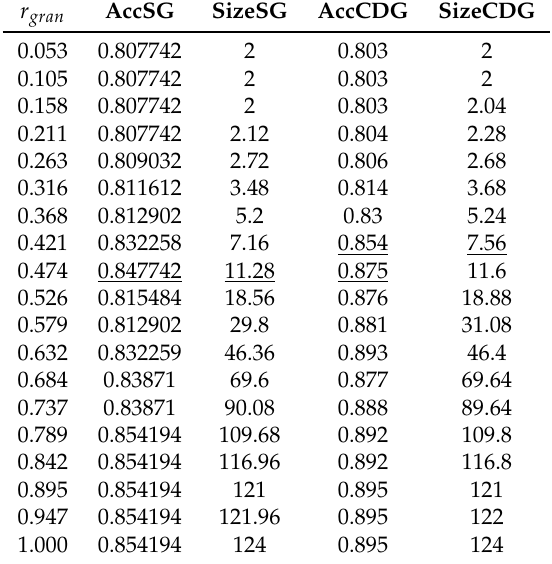
Table 14. Exemplary result for Standard vs. Concept-Dependent Granulation—5 times Cross Validation 5; Hepatitis data set; r gran = Granulation radius, AccSG = Accuracy of classification for Standard Granulation, AccCDG—Accuracy for Concept-Dependent Granulation, SizeSG = Granular decision system size for Standard Granulation, SizeCDG = Granular decision system size for Concept-Dependent Granulation. r gran AccSG